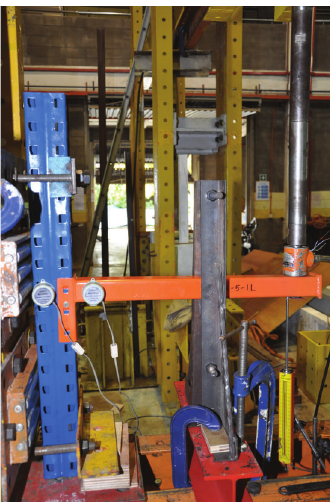
Figure 1: Typical flexural test for storage rack